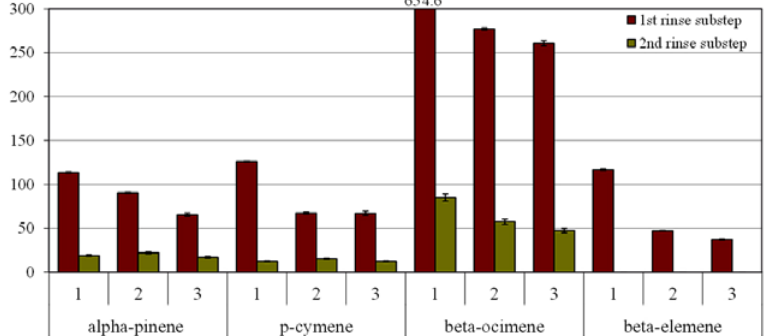
Figure 4. Distribution of the main compounds of the volatile composition of Bidens tripartita L. after three extractions of the same sample using two rinse